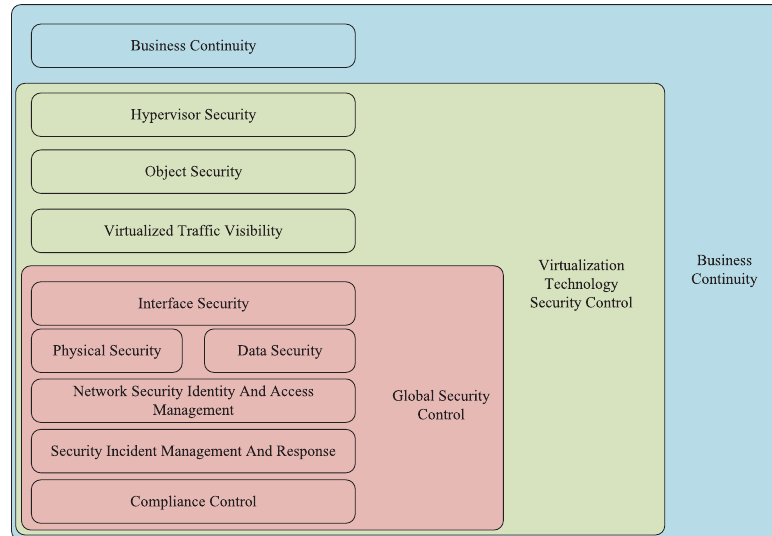
Figure 3: CSA cloud platform security